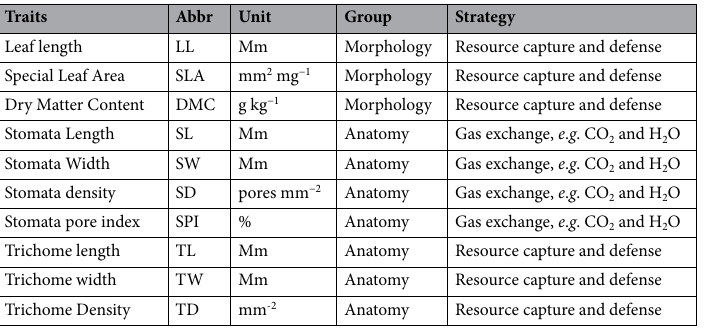
Table 5. Abbreviations, units, and description of morphological and anatomical leaf traits. Abbr: Abbreviation.